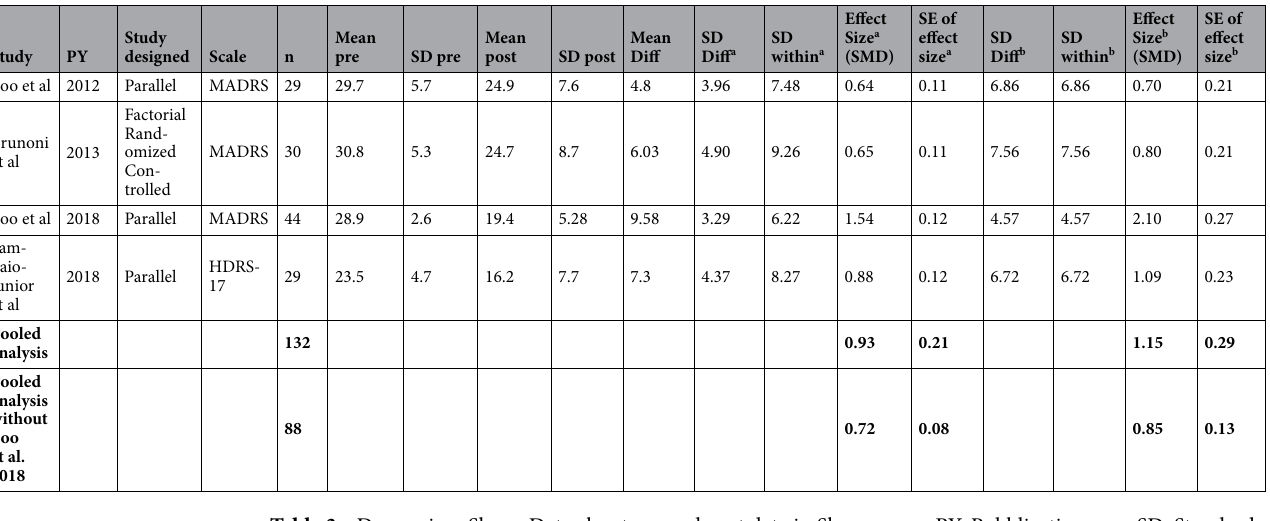
Table 3. Depression. Sham. Data about pre and post data in Sham group. PY: Pubblication year. SD: Standard Deviation. SMD = Standardized Mean Difference. SE = Standard Error. Note: a Correlation pre-post r = 0.86. b Correlation pre-post r =